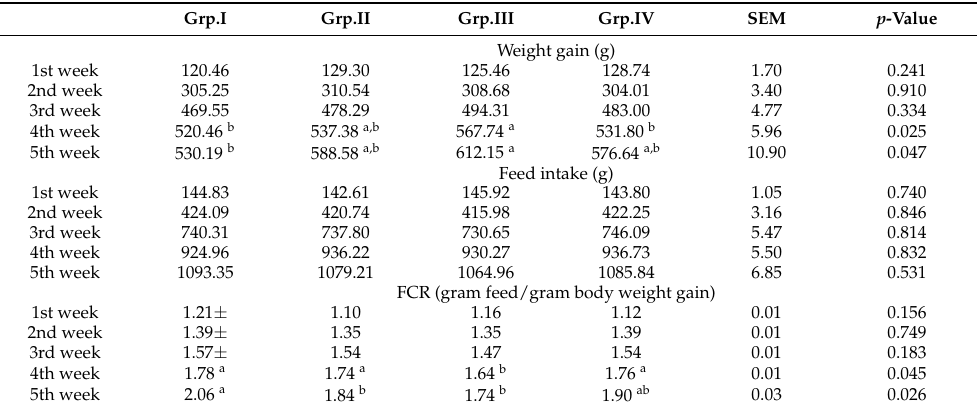
a,b Means with different superscripts (within the same row) are differ significantly ( p ≤ 0.05). Values represent the Mean ± SEM of seven replicates. Grp: group. Group-I: Control group. Group-II: B.D + activo 1 mL/3.3 L water